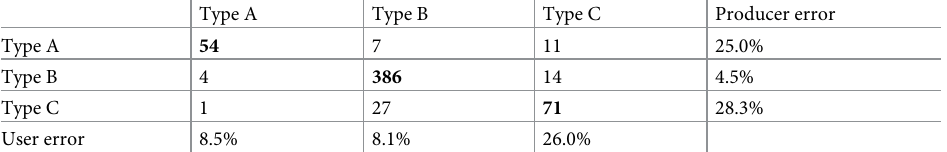
Table 2. Confusion matrix for Louisiana Waterthrush song types from a Linear Discriminant Analysis of seven song attributes. Columns are the Linear Discriminant Analysis classes. The numbers away from those in bold on the diagonal represent the